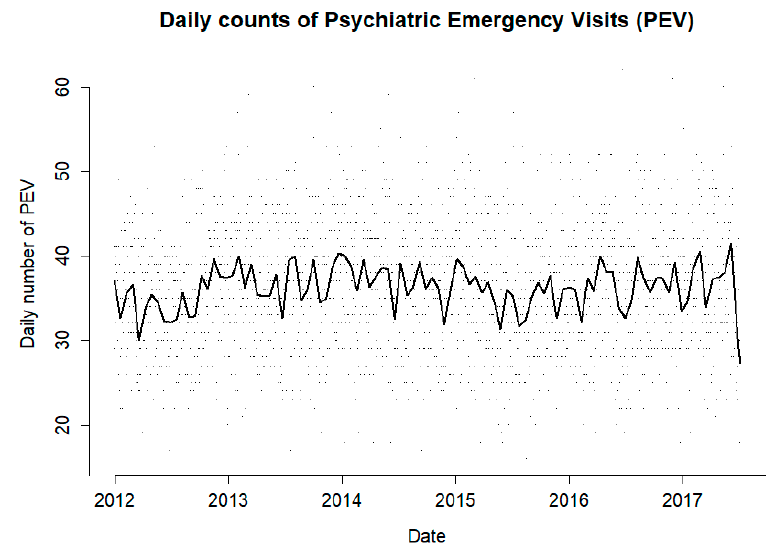
Figure 1. Daily number of individuals visiting the psychiatric emergency room (PEVs) for the duration of the study period (points) and its moving average (line).